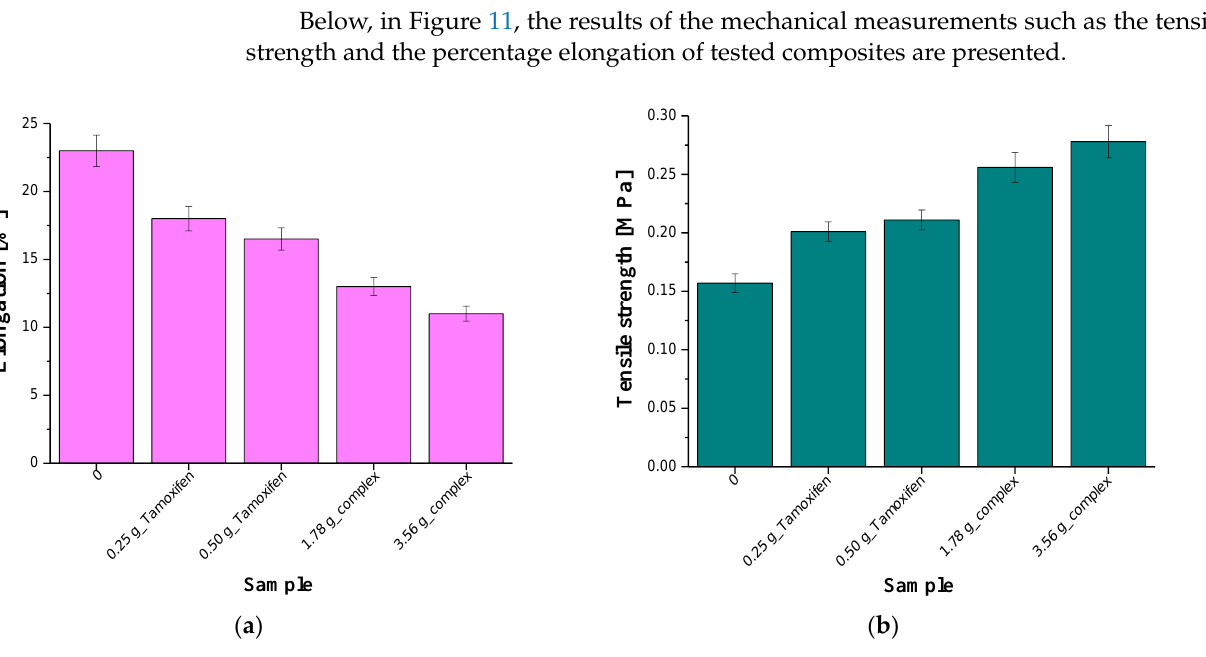
Figure 11. Results of the mechanical studies of the composites showing their elongation ( a ) and the tensile strength ( b ) (n — number of repetitions, n = 3).